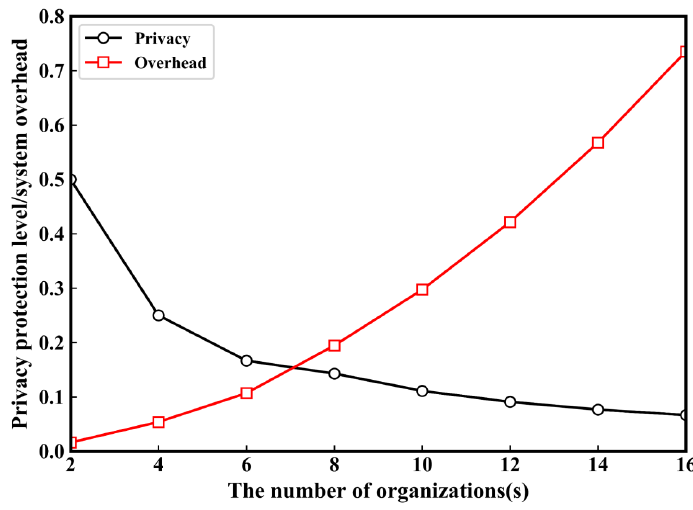
Figure 9. The balance of privacy protection level and system